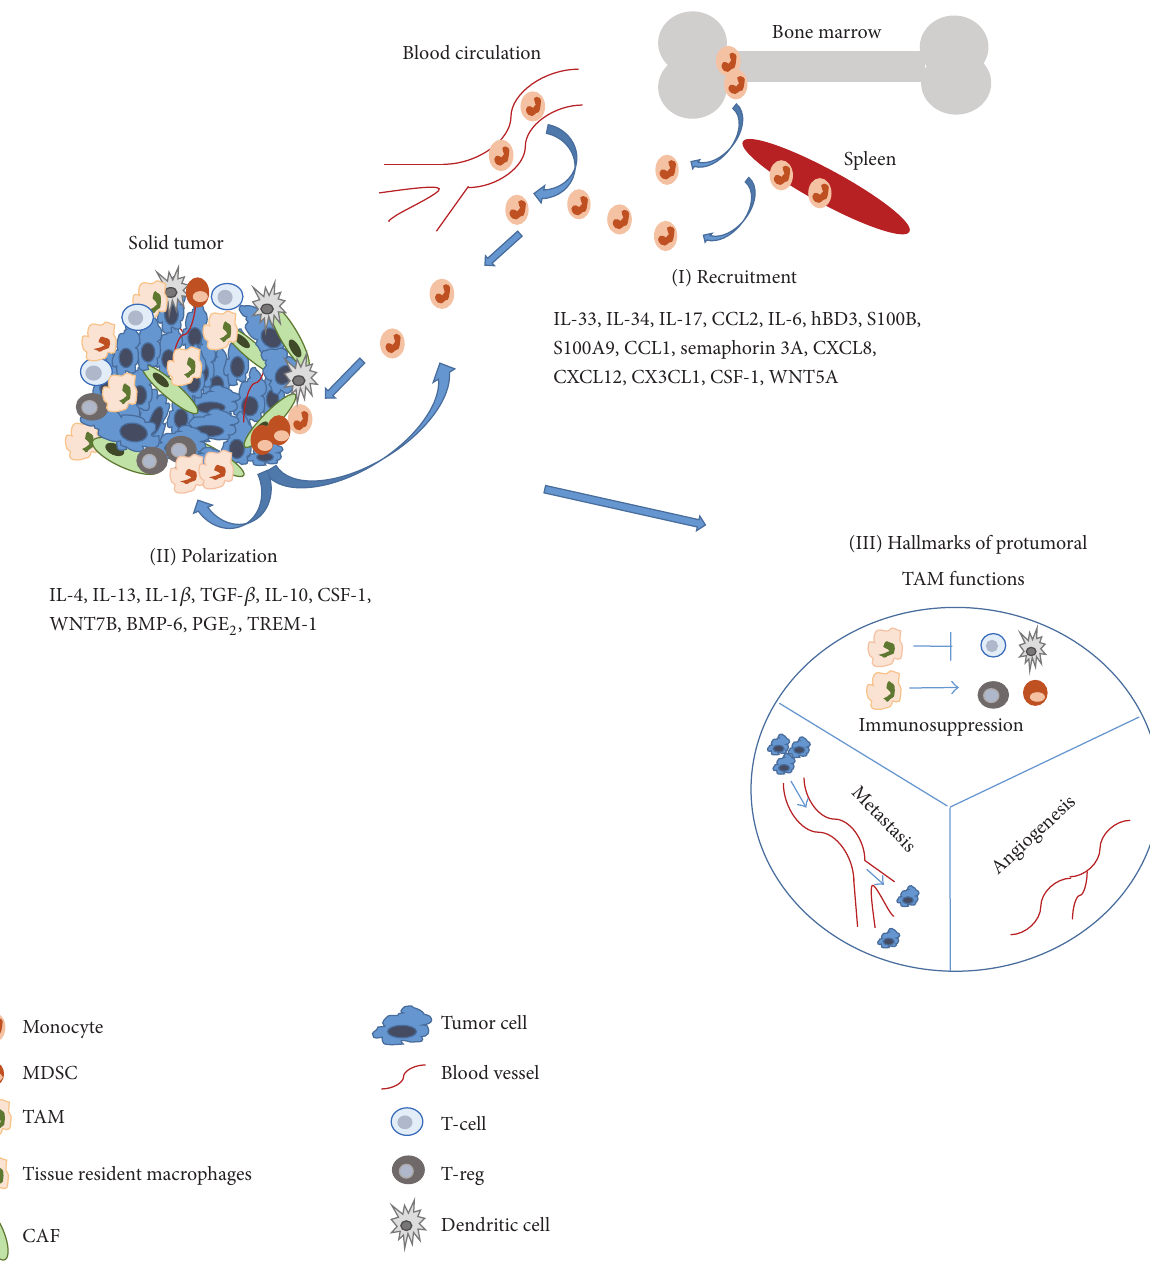
Figure 1: Solid tumors are composed of heterogeneous cell populations, comprising cancer cells, fibroblasts, endothelial cells, pericytes, and leukocytes. Among leukocytes, myeloid cell populations represent a prominent component, in terms of both number and functions, supporting tumor growth and progression. (I) Soluble mediators released by malignant cells or tumor stromal cells recruit different leukocyte populations from the circulation to the tumor site. (II) Infiltrating myeloid cells include immature MDSCs (myeloid-derived suppressor cells) or TAMs. (Factors are listed under (I) and (II) as they appear in the main text.) (III) MDSCs and TAMs exert several protumoral functions such as immunosuppression, angiogenesis, and metastasis. See detailed explanation in the relevant section of the text. CAF: cancer-associated fibroblast; TAM: tumor-associated macrophage; MDSC: myeloid-derived suppressor cell; T-reg: regulatory